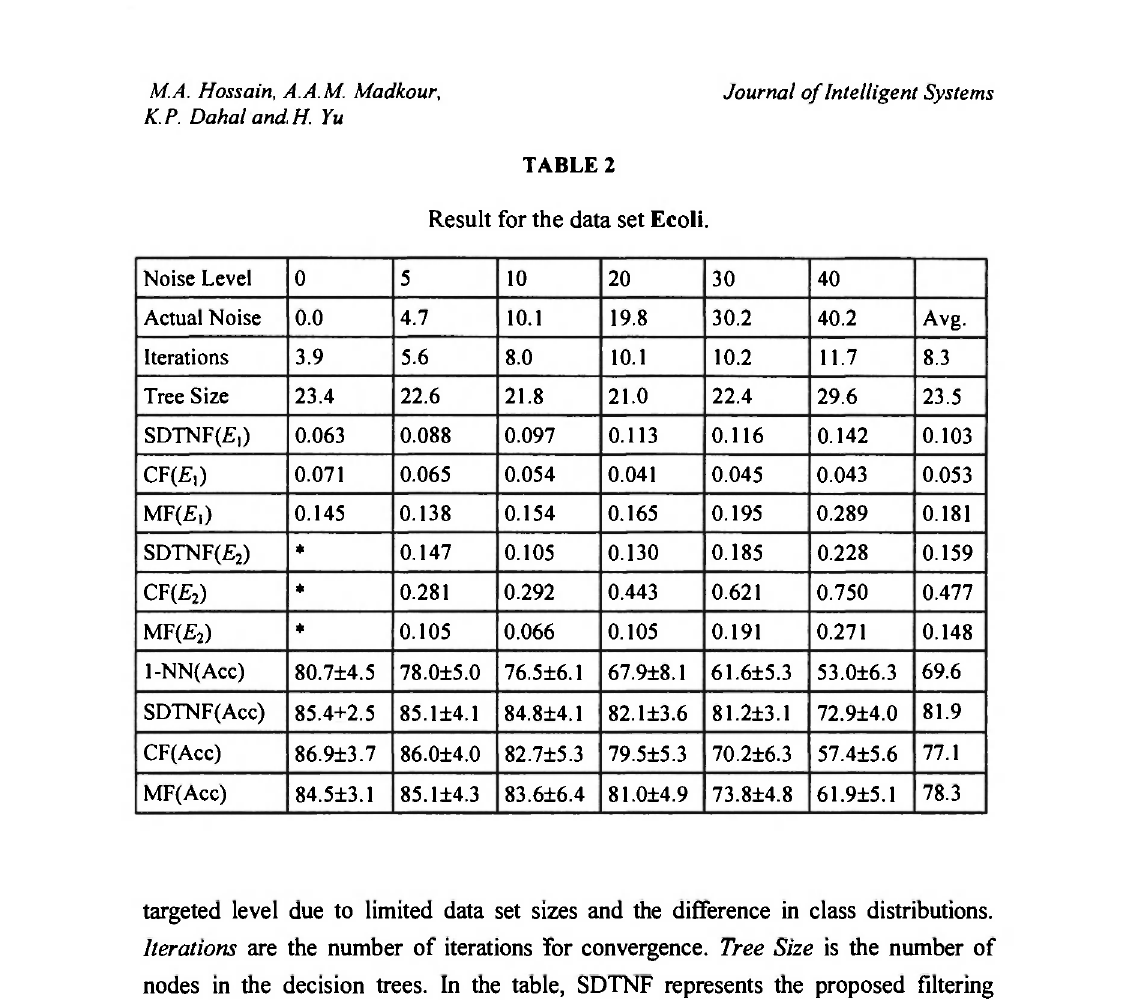
Result for the data set